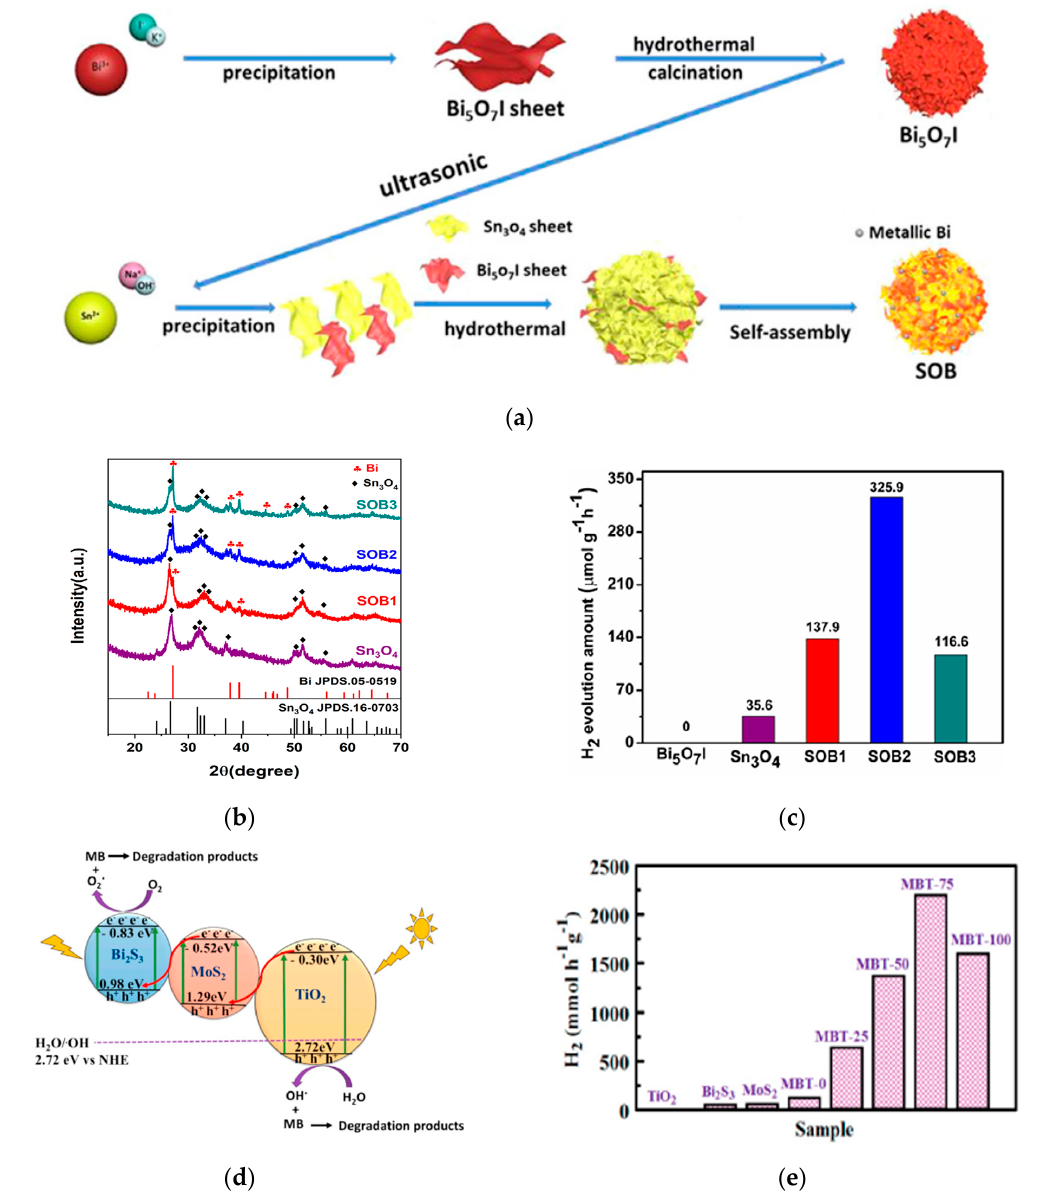
Figure 6. ( a ) The schematic diagram of Bi/Bi 5 O 7 I/Sn 3 O 4 preparation process;( b ) X-ray diffraction (XRD) patterns of Sn 3 O 4 and Bi/Bi 5 O 7 I/Sn 3 O 4 complexes (Bi/Bi 5 O 7 I/Sn 3 O 4 samples doped 15 mg, 30 mg, and 45 mg Bi 5 O 7 I were labeled as SOB1, SOB2 and SOB3, respectively); ( c ) Average hydrogen production of Sn 3 O 4 and SOB heterojunction within 5 h. Reproduced with permission from [99]. Copyright Elsevier, 2020; ( d ) Mechanism diagram of Z-scheme Bi 2 S 3 /MoS 2 /TiO 2 heterojunction; ( e ) Comparison of H 2 production performance of Bi 2 S 3 /MoS 2 /TiO 2 (MBT) samples with different TiO 2 contents. Reproduced with permission from [104]. Copyright Elsevier, 2020.